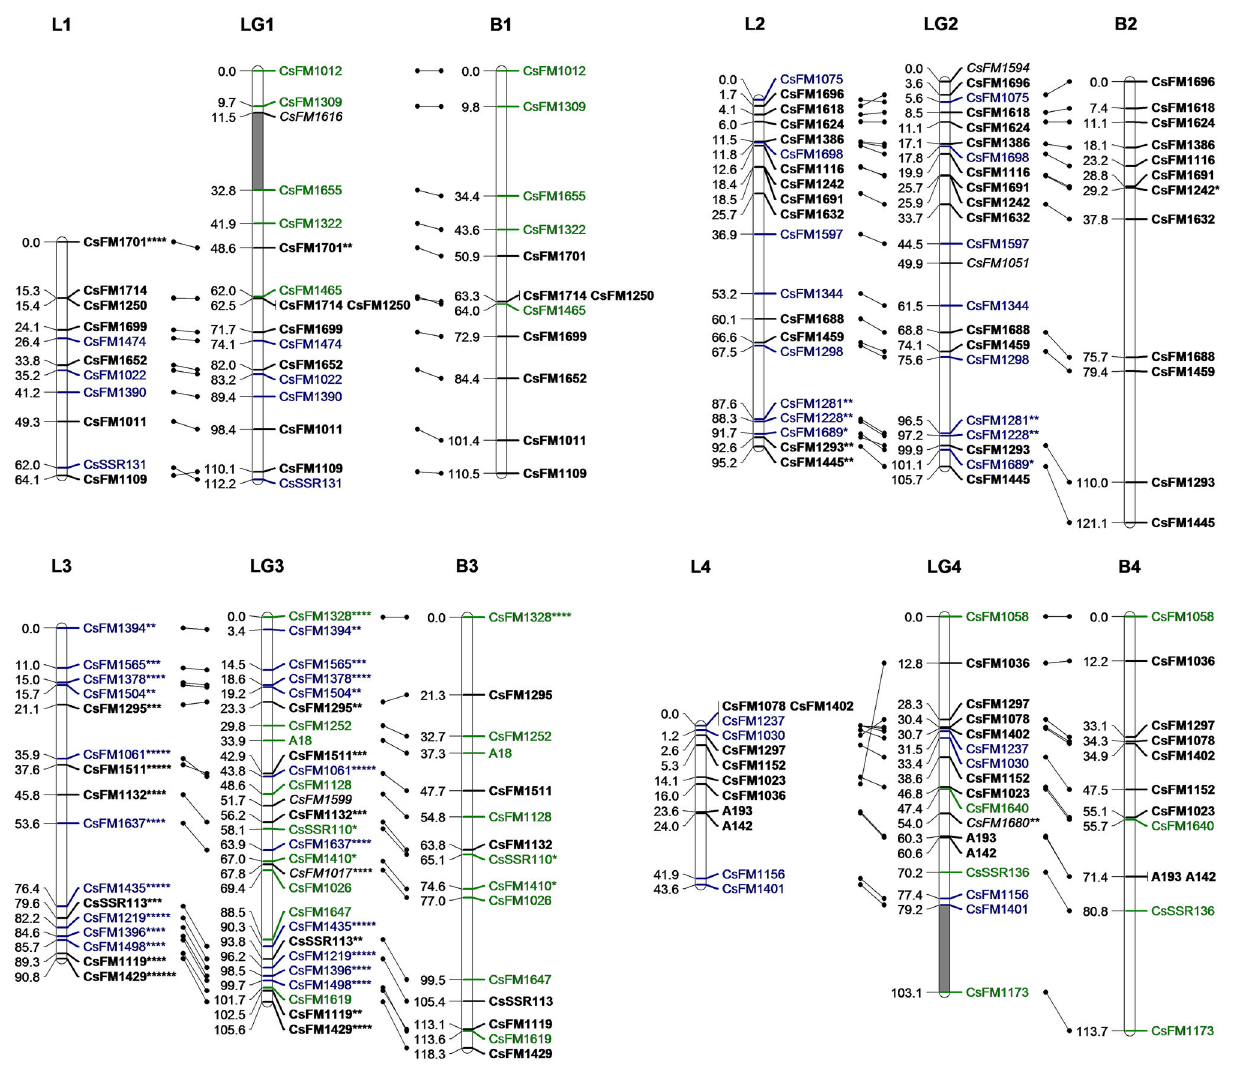
Figure 3. Linkage map based on SSR markers for C . sinensis (LG1-4). The map in the middle (LG1–LG15) is the consensus map constructed from the combined dataset. The map on the left (L1–L15) and right (B1–B15) are the maternal (Longjin43) and parental (Baihaozao) maps, respectively. Homology between these is depicted by lines with dots on both ends. Markers to describe both parents are bold (ab×cd or ef×eg), markers for Longjin43 only are blue (lm×ll), markers for Baihaozao only are green (nn×np). Italic markers are hk×hk segregation types. Grey bars in the consensus map indicate gaps longer than 20 cM. Distorted markers are indicated with *, **, ***, ****, ***** and ******, where P = 0.05, 0.01, 0.005, 0.001, 0.0005 and 0.0001, respectively. doi: